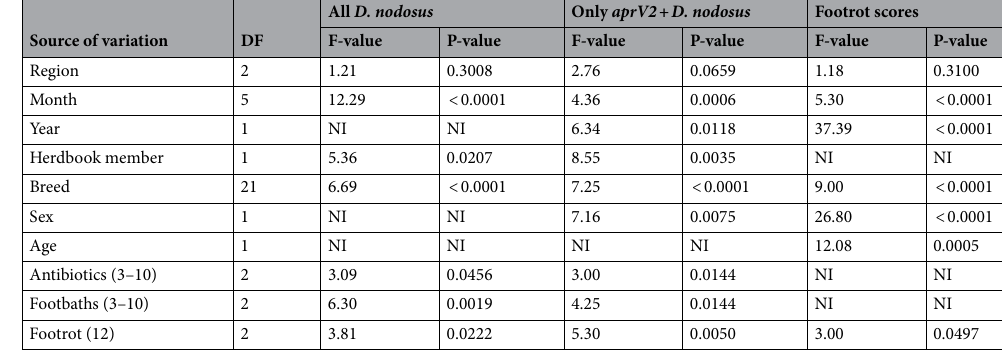
Table 2. Results of the final generalized mixed linear model using a binomial distribution function and logit as link function with the significant effects (p-value < 0.05), their degrees of freedom (DF) and F-values associated with the presence of D. nodosus ( aprV2 + /aprB2 +) and only virulent D. nodosus ( aprV2 +) in the individual sheep. NI not included in the final model. An ordered multinomial distribution function and cumulative logit as link function was used in the final generalized mixed linear model analysis of footrot scores.